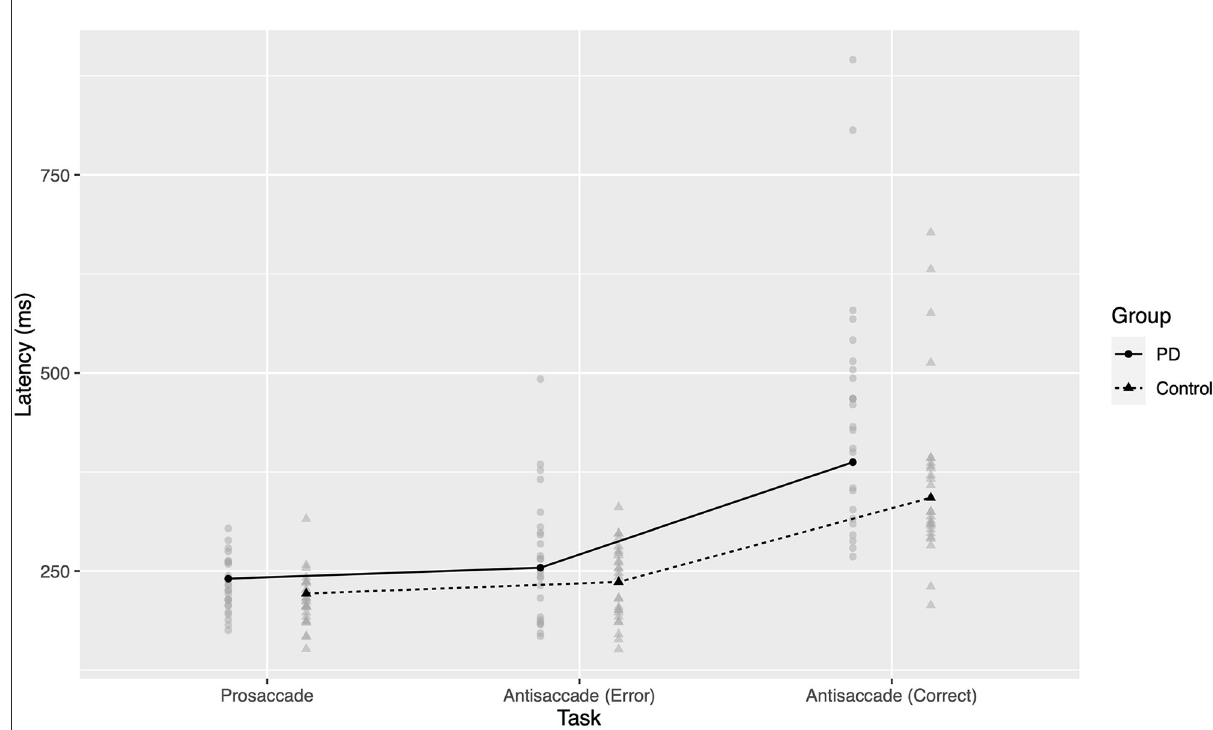
FIGURE2 Latency to response across groups and tasks. Gray points represent mean latency for one participant in a given task. Black points and lines represent estimated marginal group